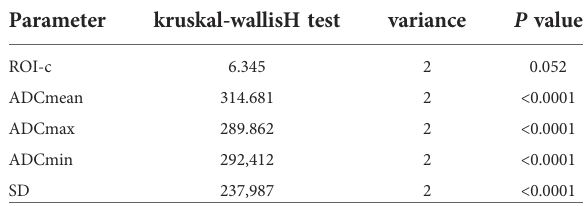
TABLE 2 Kruskal-wallisH test.